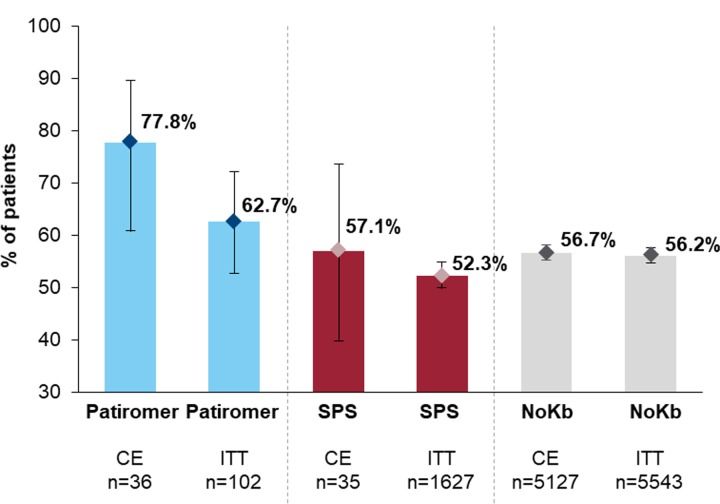
Percentage (95% CI) of patients continuing RAASi* therapy: By treatment group and exposure classification (CE, ITT).*RAASi included: ACE inhibitors, ARBs, MRAs, and DRIs. CE, continuous exposure; CI, confidence interval; ITT, intention-to-treat; NoKb, no potassium binder; RAASi, renin-angiotensin-aldosterone system inhibitor; SPS, sodium polystyrene sulfonate.